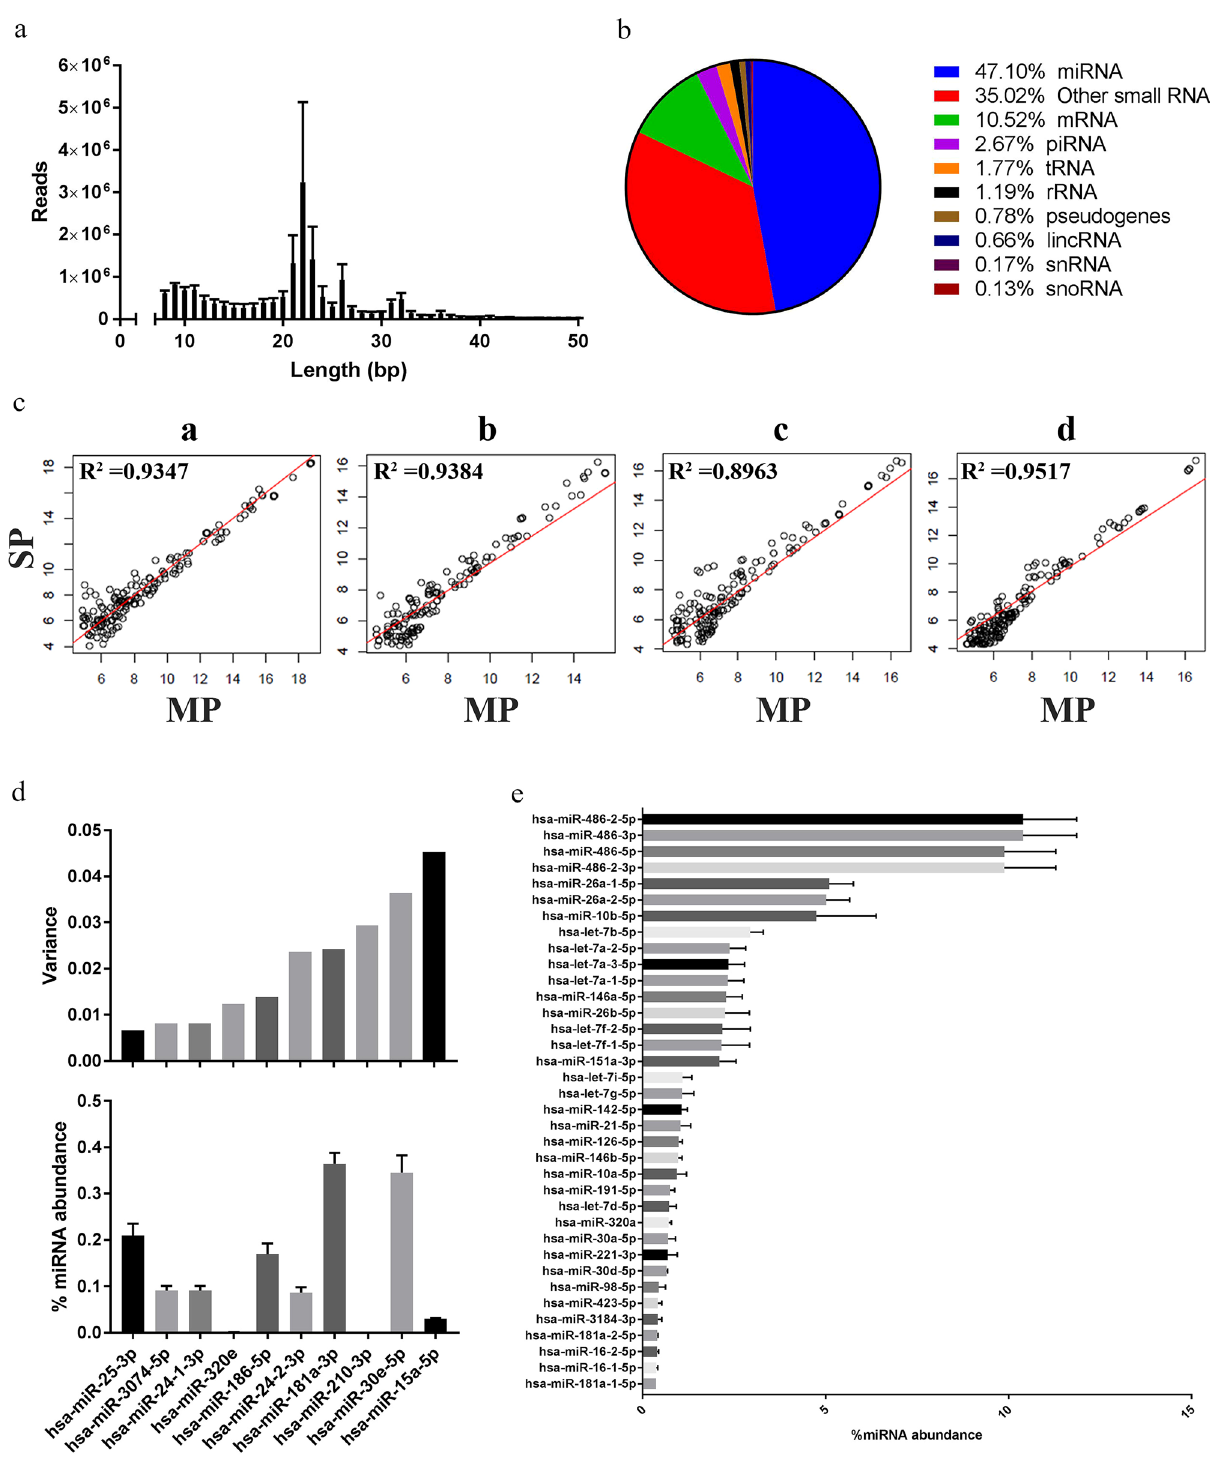
Figure 5. Small RNA sequencing (sRNAseq) results for RNA extracted from Vn96-isolated plasma EVs (n = 4). ( a ) Average number of reads ± SEM versus read length (bp). ( b ) Distribution of sRNA species in Vn96- isolated plasma EVs. ( c ) Regression plot of each patient miRNA result extracted by single parametric (SP) versus multiparametric (MP). ( d ) Top ten lowest variant miRNA (top) compared to their % of total miRNA abundance ± SEM (bottom). ( e ) Top 36 abundant miRNA expressed as % of total miRNA abundance ±